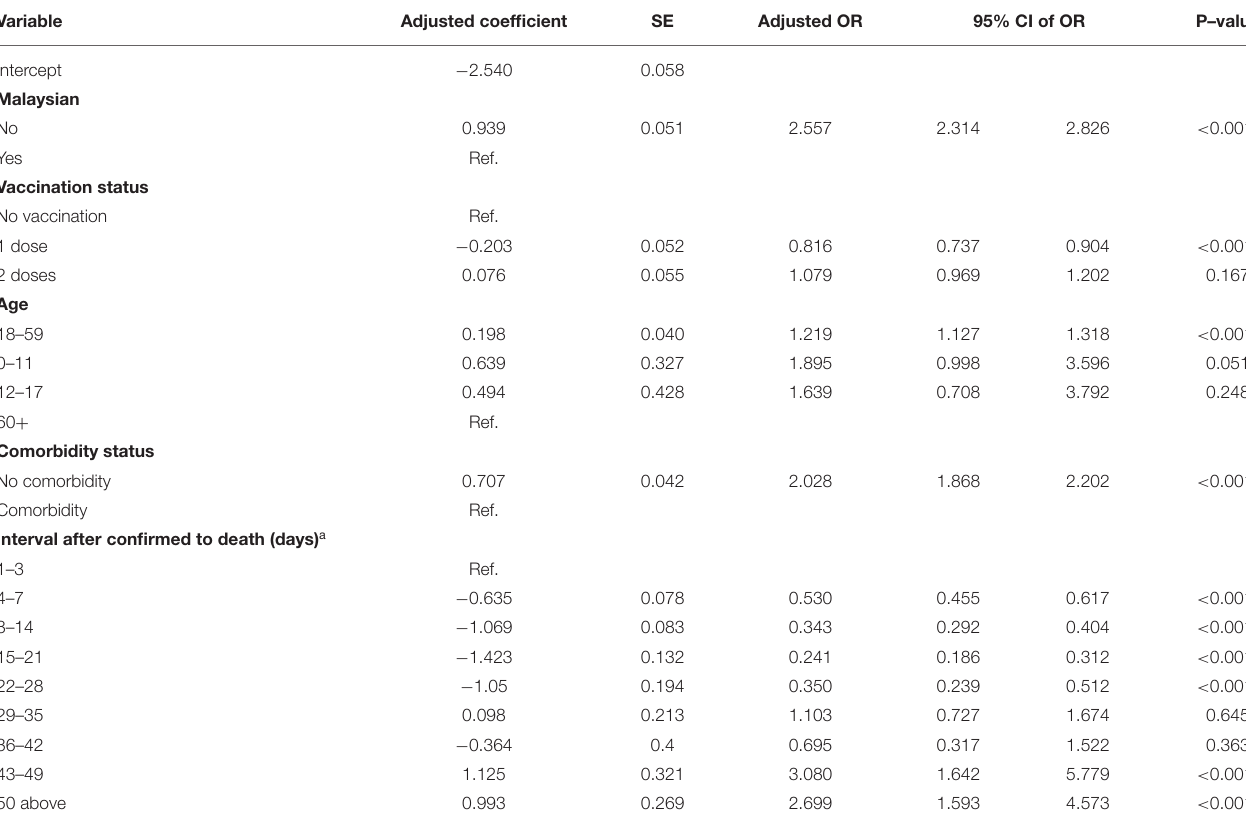
TABLE 4 | Factors associated with probability to BID using the multiple multilevel logistic regression model.